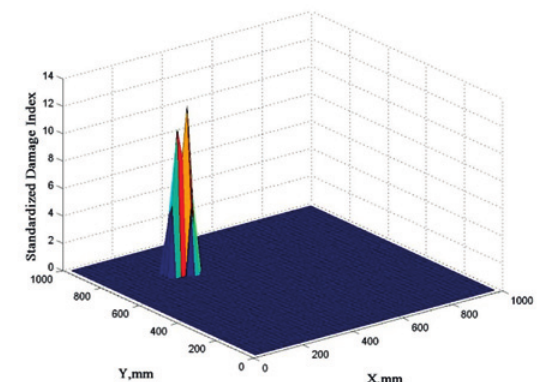
fig. 7. Standardized MSCS damage index for test case 3.3 after truncation